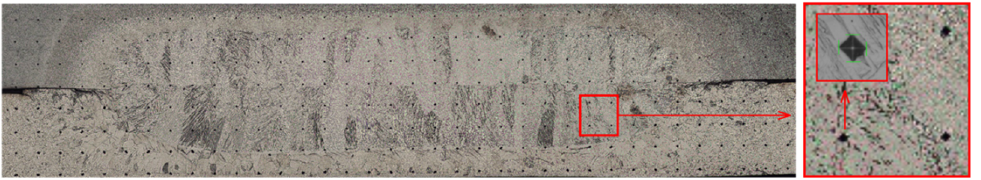
Figure 13. Maps of indentations after hardness measurement.